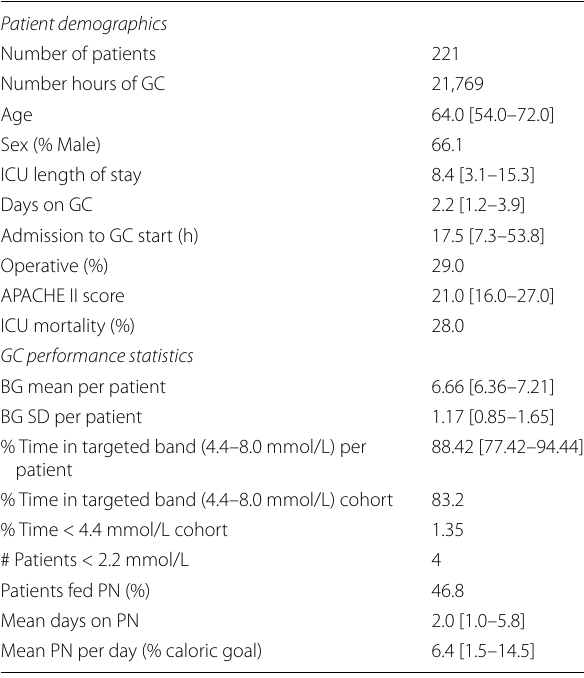
Table 1 STAR cohort patient demographics and GC perfor- mance statistics